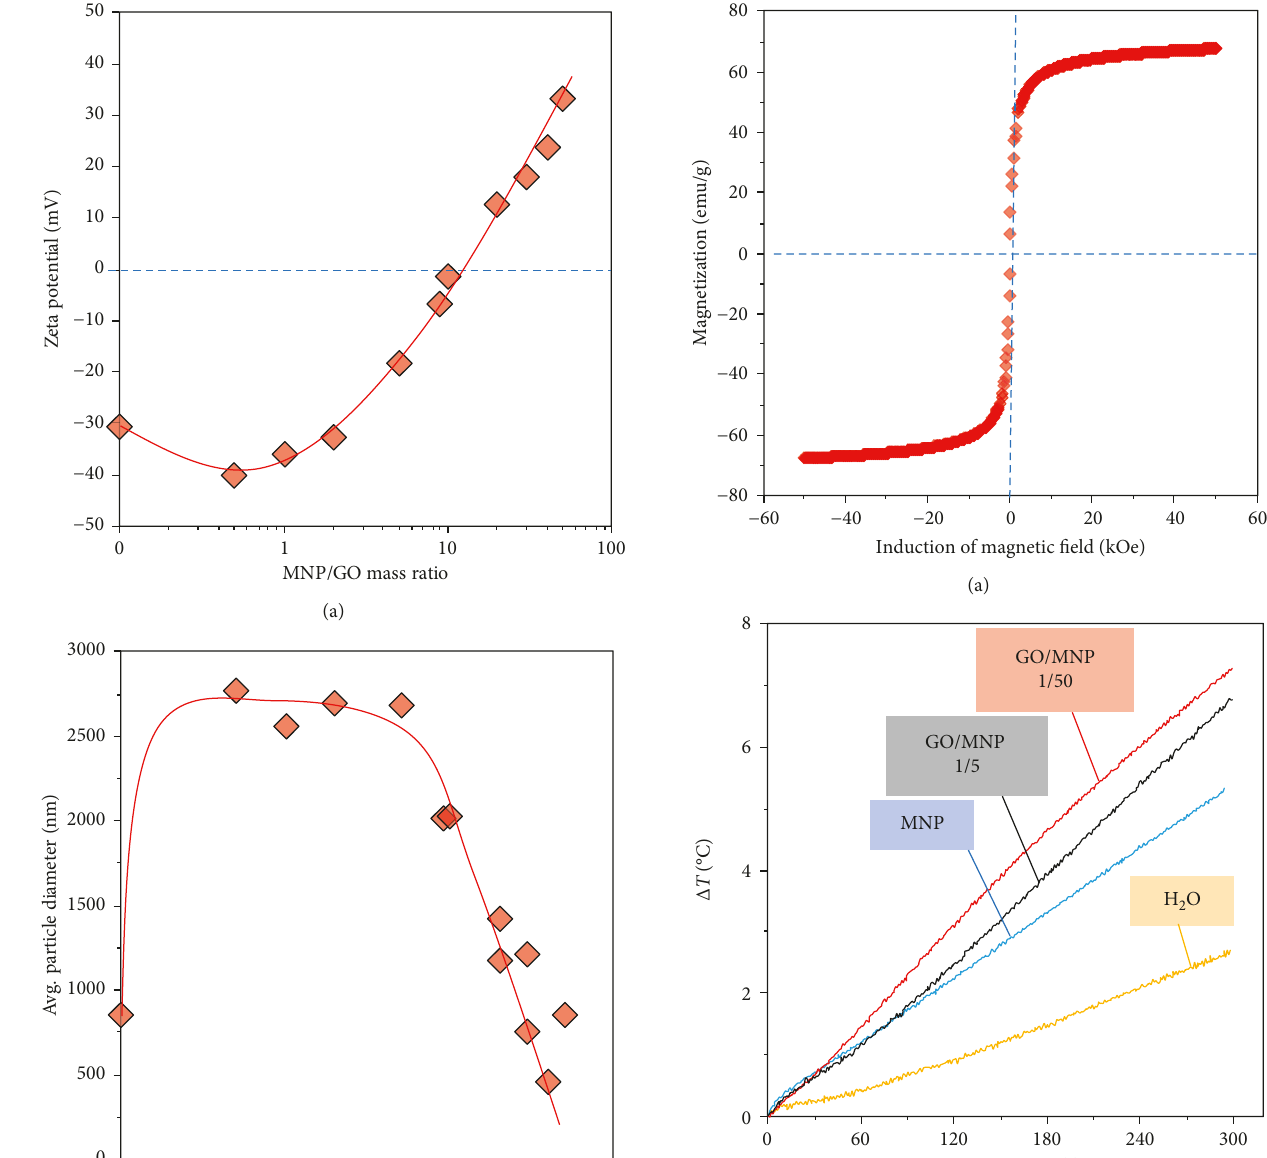
persed to the submicrometer level ( d ave